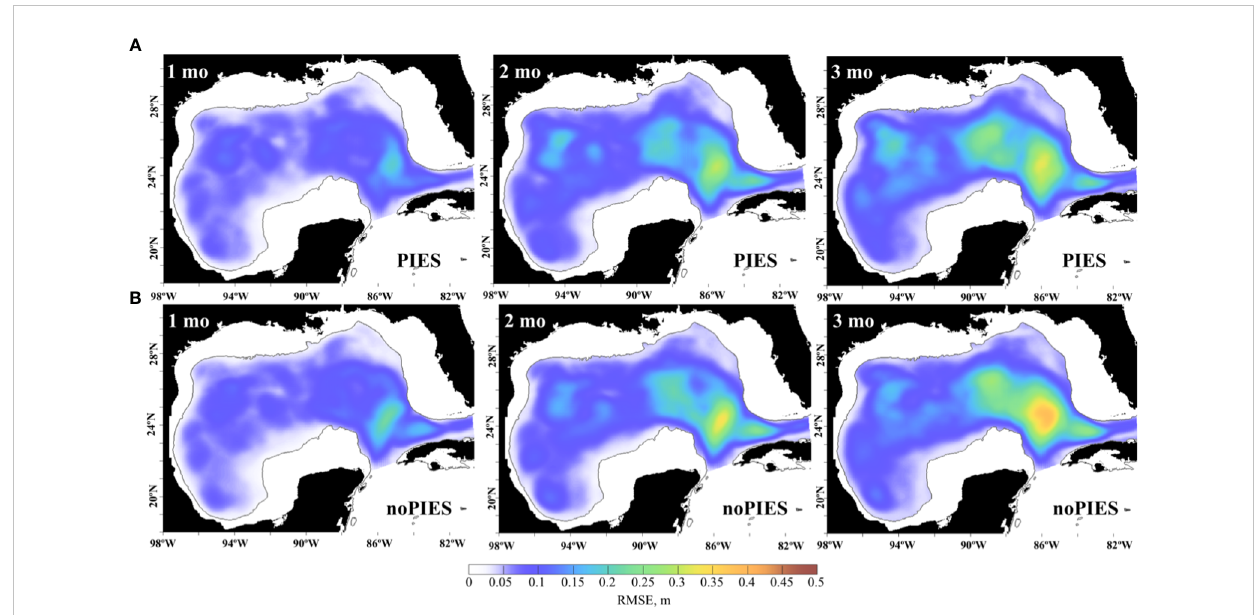
FIGURE 5 Monthly mean RMSE between daily SSH (m) from the OSE 3-month forecasts in 2009 – 2010 and from the 0.04GOM reanalysis. The forecasts initialized from the OSE with PIES T/S pro fi les (top row, A ) and the OSE with no PIES T/S pro fi les (bottom row, B ). The RMSE is averaged by the forecast months (in columns), so that the monthly statistics are derived from roughly 30 days of 20